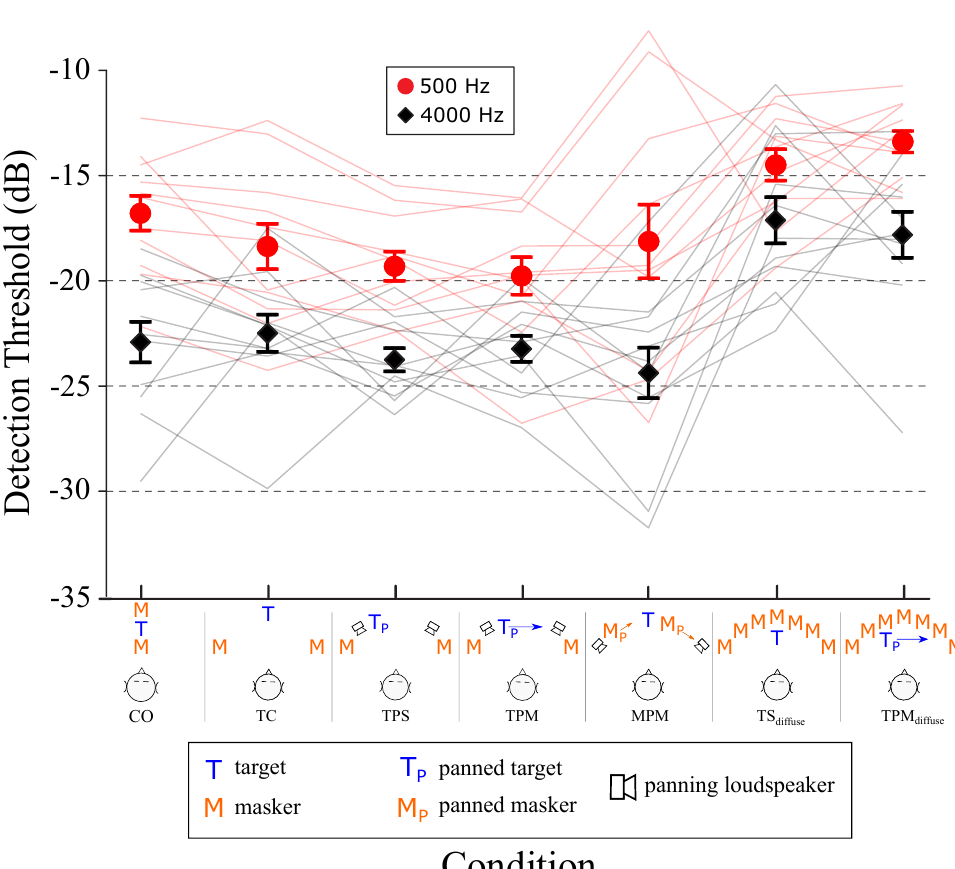
Figure 2. Mean tone–in–noise detection thresholds across 11 listeners, in terms of the difference between the levels of the maskers and the target, in decibels. Negative thresholds mean that the target energy was less than that of the maskers. Error bars indicate the variability across listeners as ± 1 standard error of the mean. Individual data are represented with thin lines connecting performance for each condition, and are color coded the same as the mean data. Stimulus conditions are schematically illustrated along the horizontal